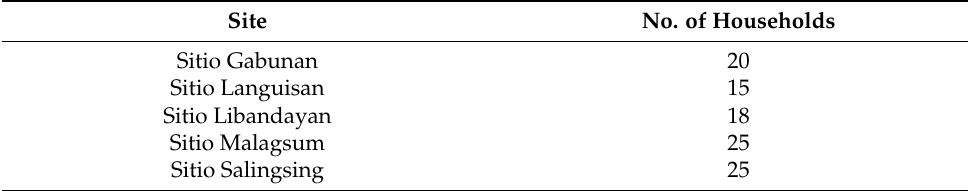
Figure 4. Daily average flow rate of the Malikongkong River. Table 1. Selected unelectrified sites with corresponding number of